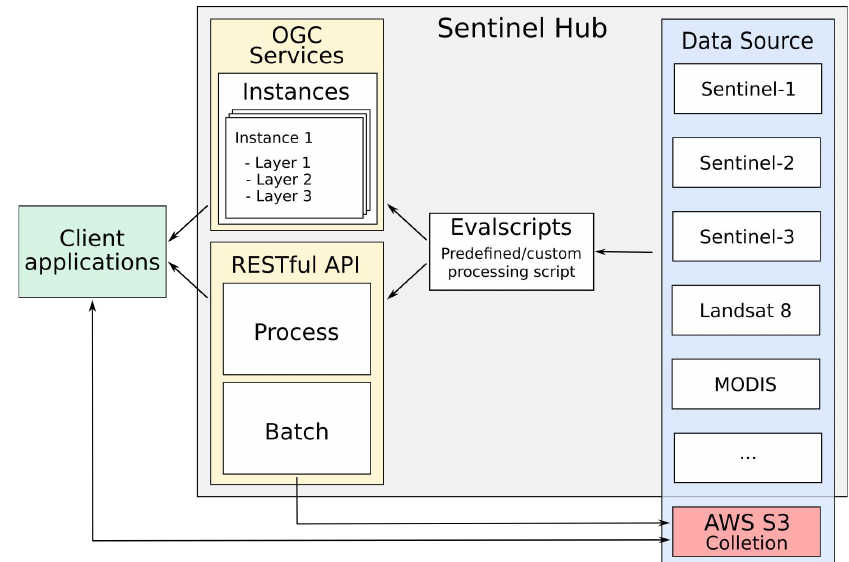
Figure 2. Sentinel Hub (SH) services and data abstraction